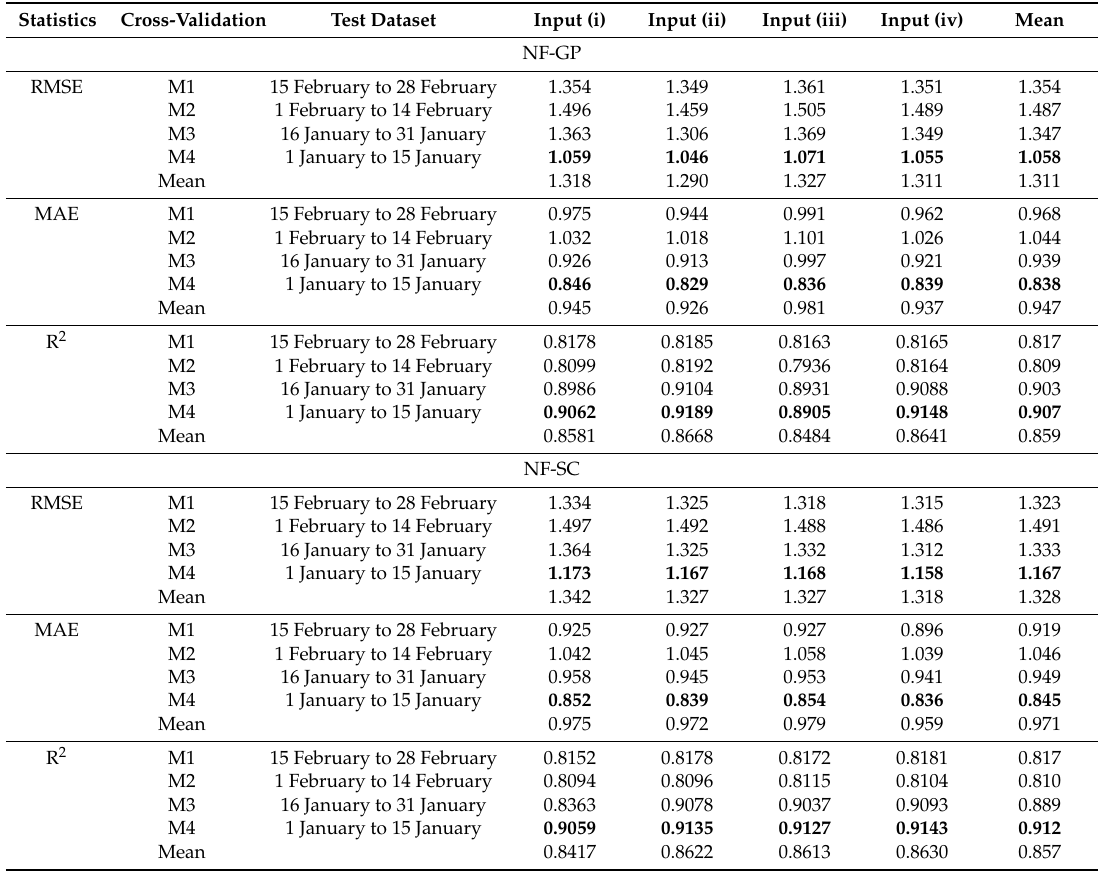
Table 2. The neuro-fuzzy grid partition (NF-GP) and neuro-fuzzy sub-clustering (NF-SC) model results in wind speed prediction. RMSE—root-mean-square error; MAE—mean absolute error; R 2 —coefficient of